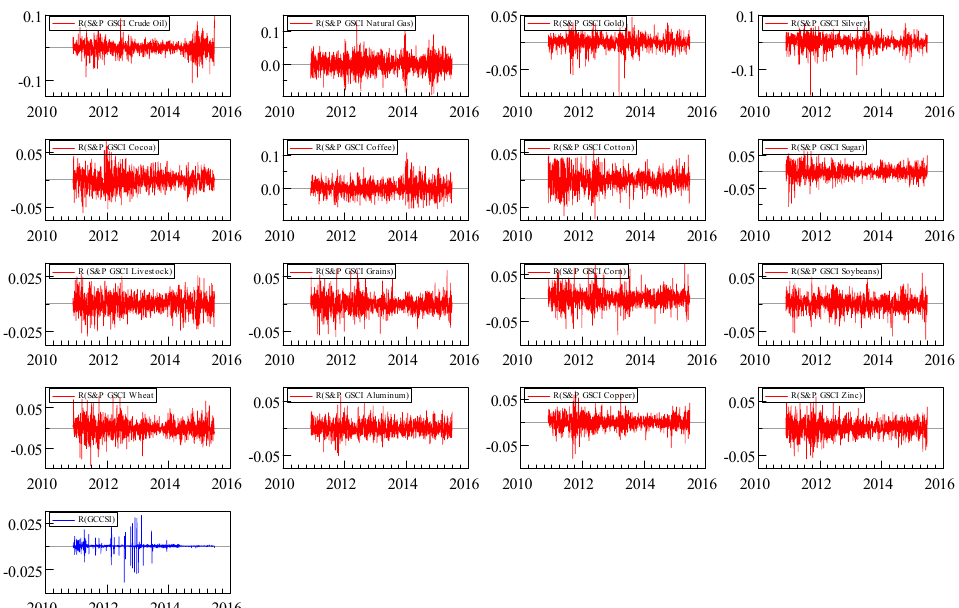
Figure 3. Return dynamics of commodity and sukuk indices.